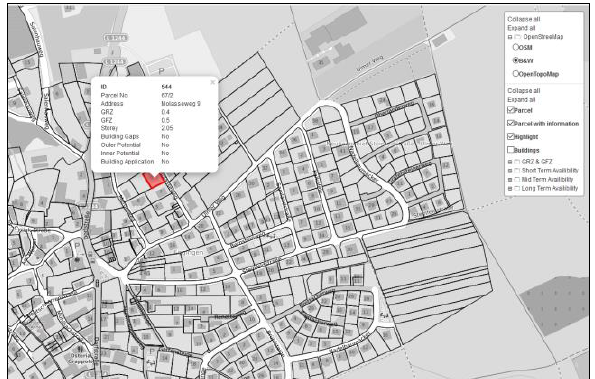
Figure 9 : Highlight feature and Land